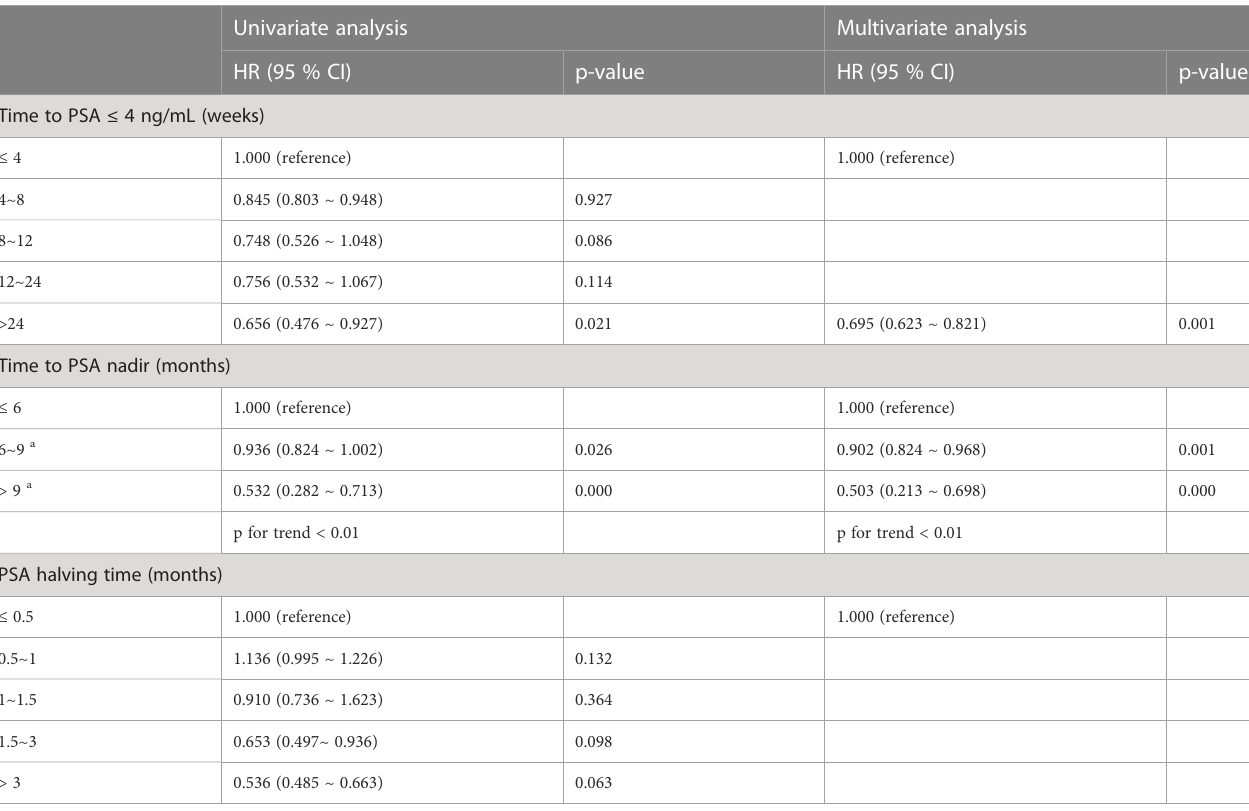
TABLE 4 Cox regression analysis of the relationship between the PSA halving time and bPFS.